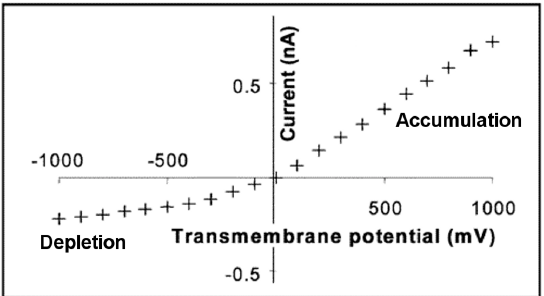
Figure 8. Rectified I-V curve in 0.1 M KF (pH 6.6) measured across a PET membrane containing gold conical nanotubes modified with mercaptoethylammonium cations. Reproduced with permission from [16]. American Chemical Society, 2004.